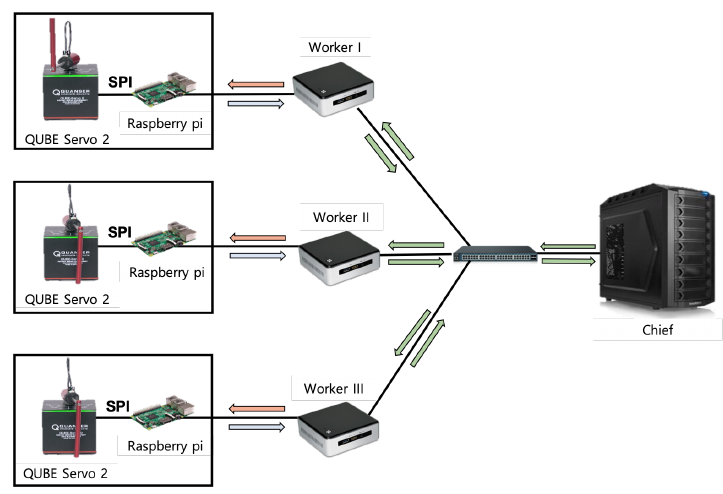
Figure 4. Our experiment configuration with multiple rotary inverted pendulum (RIP) devices, multiple workers, and one chief.